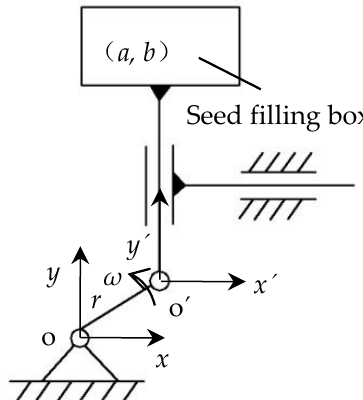
Figure 4. Motion diagram of driving components and seed filling box mechanism.